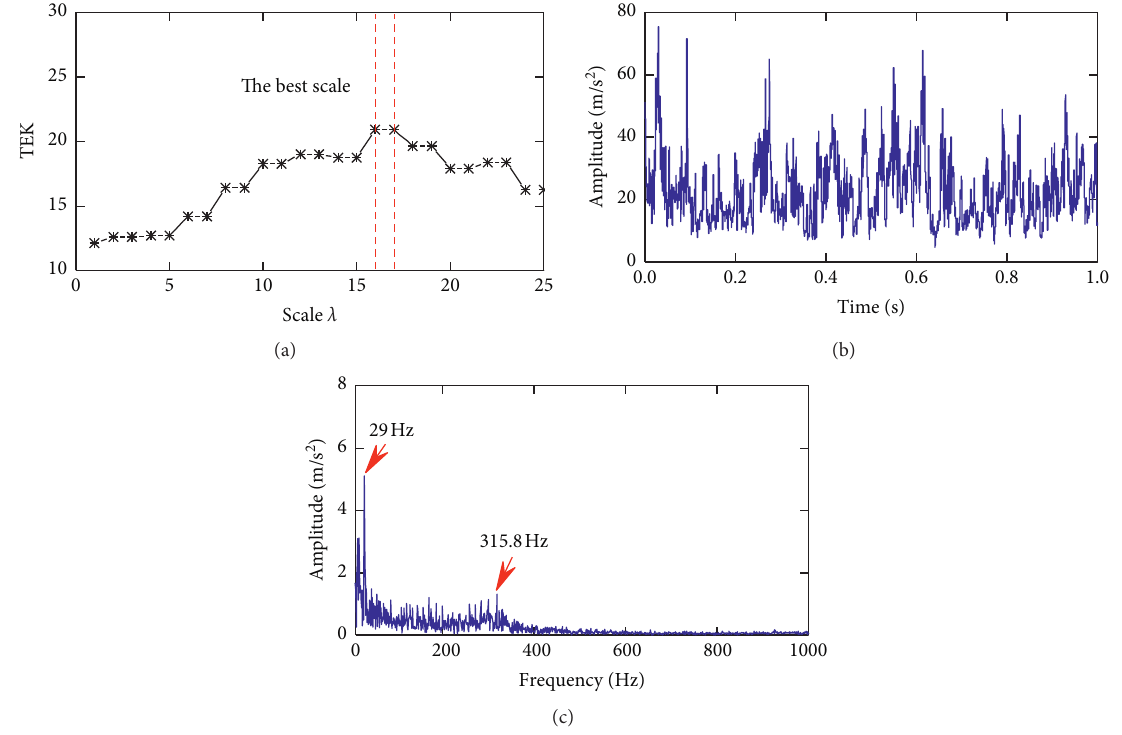
Figure 21: Analysis results of experimental signals by the ACDIF method: (a) correlation curve between TEK and scale λ ; (b) time-domain spectrum; (c) envelope spectrum.